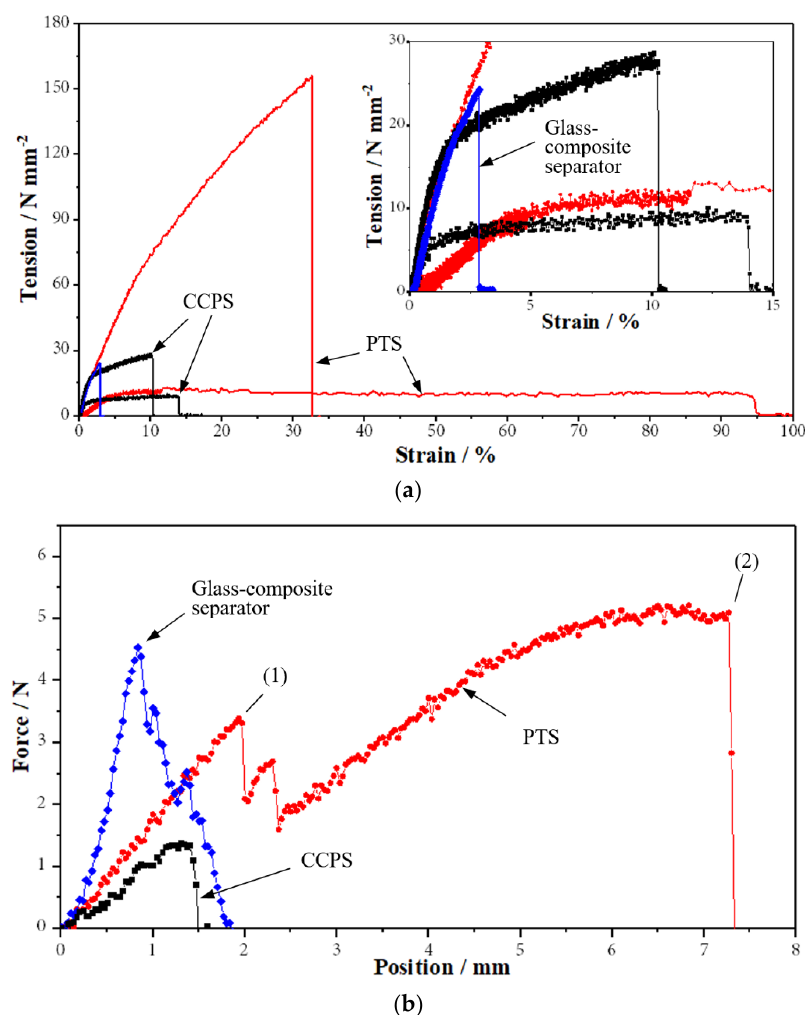
Figure 7. Mechanical stability of a glass composite separator, CCPS, and PTS, ( a ) tensile strength in the machine direction (MD) and transverse direction (TD); ( b ) puncture strength.